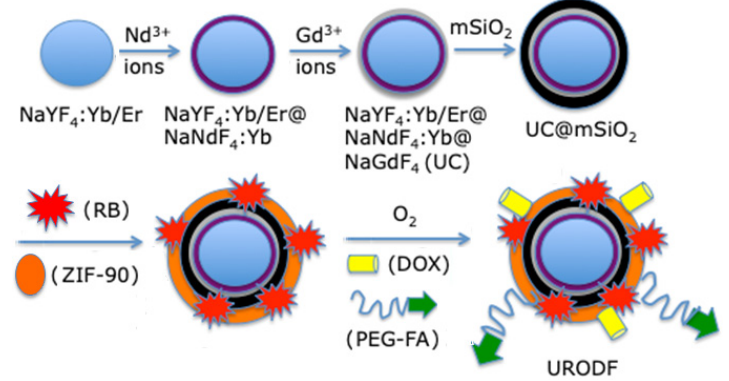
Figure 13. Preparation of URODF NPs. Adapted from Xie et al. [34].